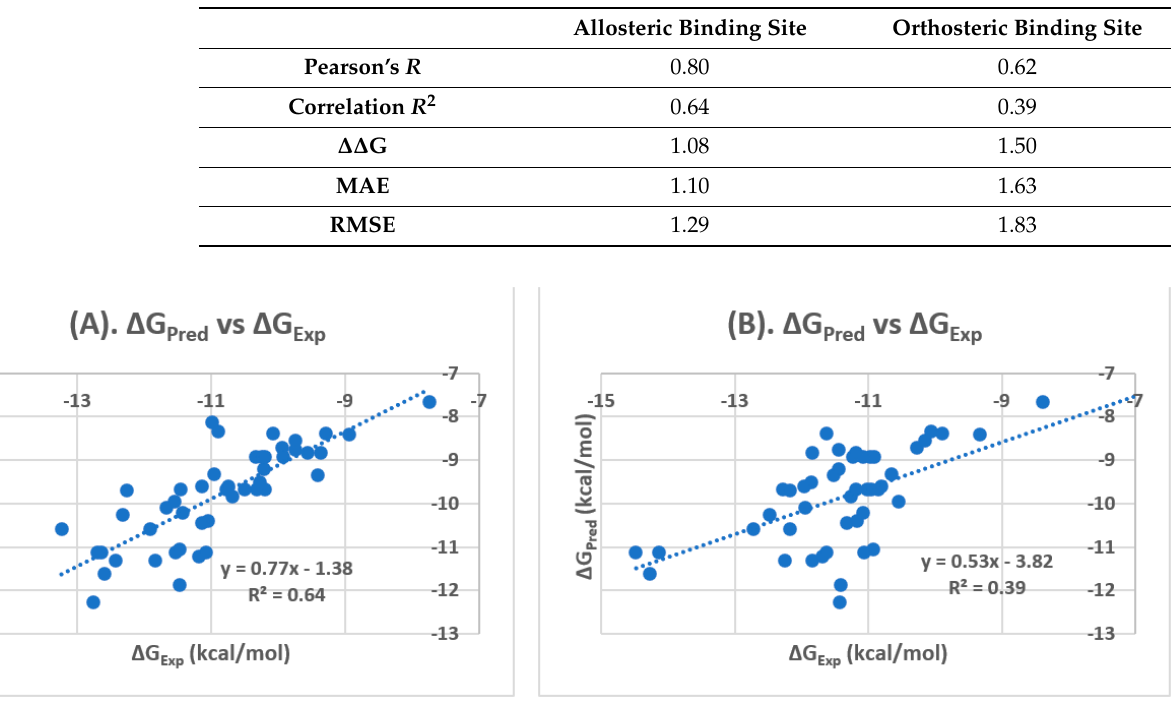
Figure 2. Correlations of glide docking scores for PPAR γ antagonists: ( A ) Allosteric Binding site. ( B ) Orthosteric Binding Site.